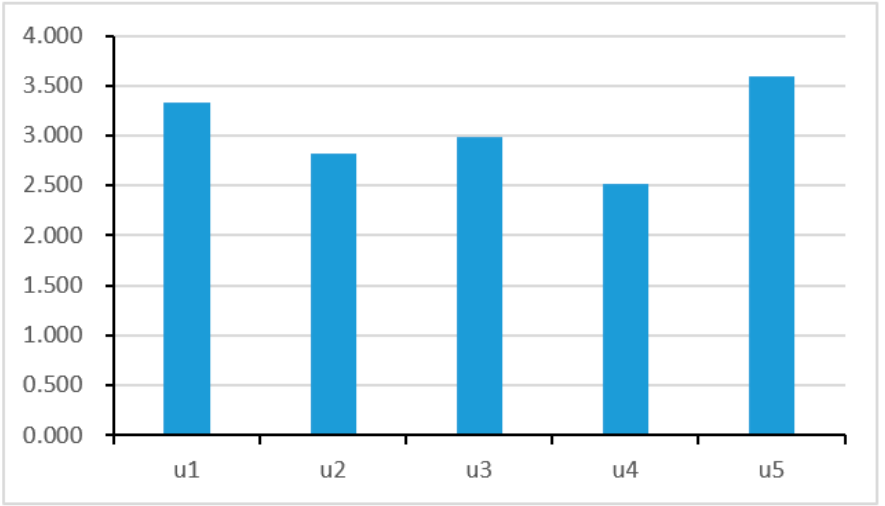
Figure 2. Social stability risk level of first-level risk factors.